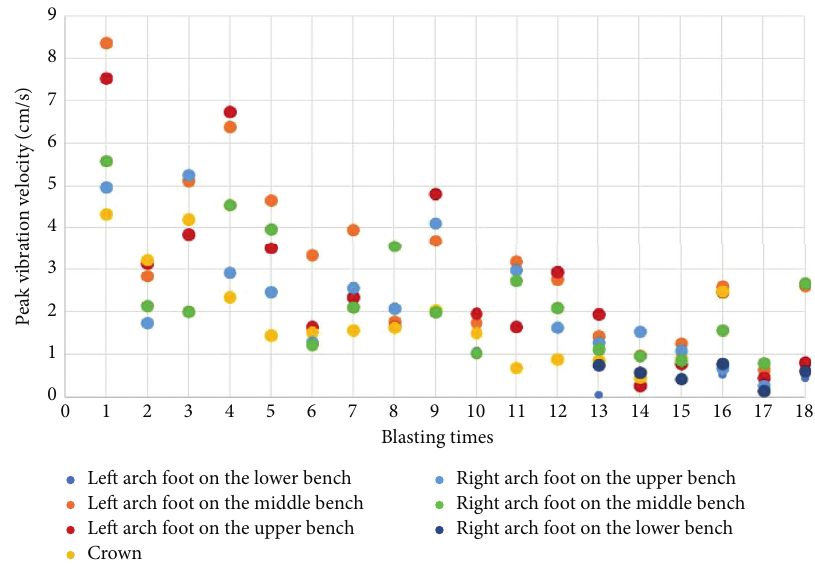
Figure 14: Contrast diagram of vertical vibration velocity at different positions of the